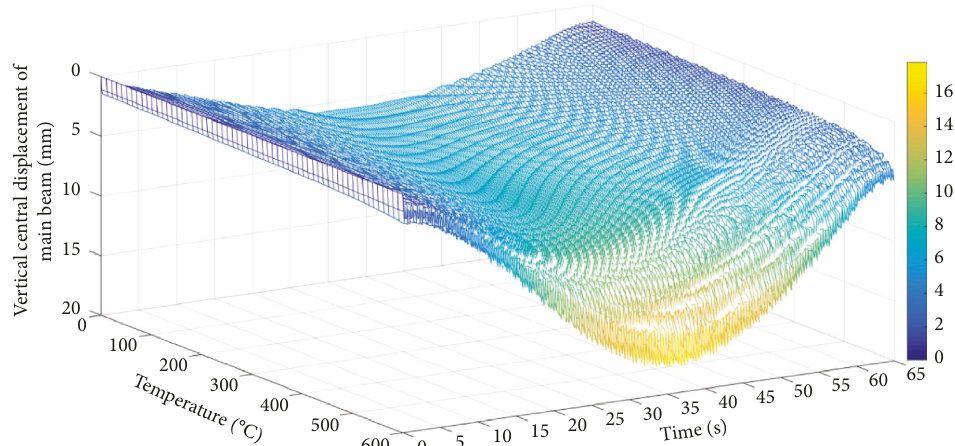
Figure 12: 3-D graph of the domain response of the main beam at different temperatures.